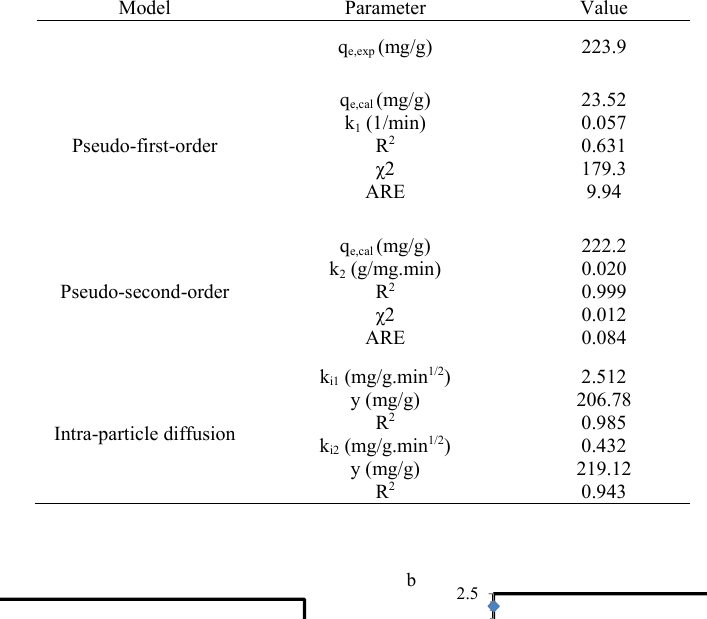
Table 5. The adsorption kinetics of MB dye